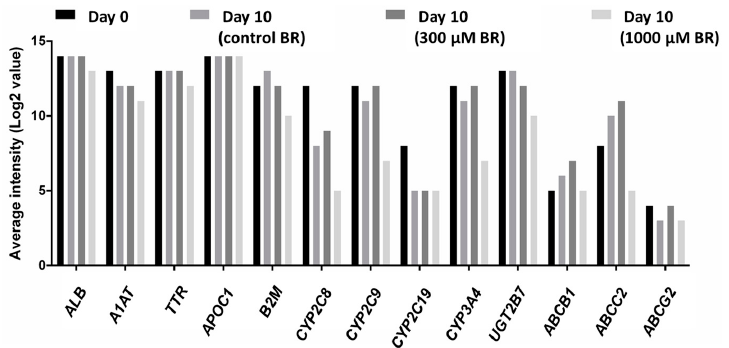
Figure 7. Microarray analysis of primary human liver cells cultured in bioreactors with or without diclofenac exposure. The graph shows average intensities of key genes involved in diclofenac metabolism and diclofenac-mediated toxicity determined in freshly isolated liver cells (Day 0) or cells cultured in bioreactors until Day 10 without diclofenac (control bioreactors (control BR)) or with diclofenac (300 µM bioreactors (300 µM BR)) or 1000 µM bioreactors (1000 µM BR)). Measured genes include albumin ( ALB ), α -1-antitrypsin ( A1AT ), transthyretin ( TTR ), apolipoprotein C-I ( APOC1 ), β -2-microglobulin ( B2M ), selected cytochrome P450 (CYP) isoenzymes, uridine diphosphate (UDP) glucuronosyltransferase 2B7 ( UGT2B7 ), ATP-binding cassette B1 ( ABCB1 ), ATP-binding cassette C2 ( ABCC2 ), and ATP-binding cassette G2 ( ABCG2 ) (control BR ( n = 6), 300 µM BR ( n = 4), 1000 µM BR ( n = 3)).